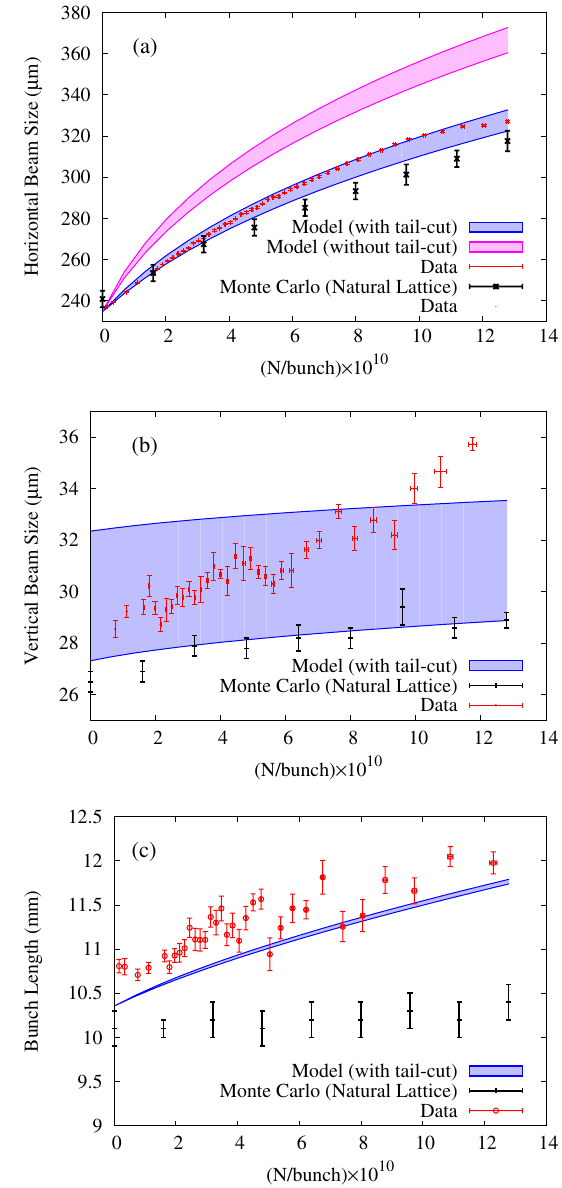
FIG. 9. (a) Horizontal, (b) vertical, and (c) longitudinal beam size versus current for e þ bunch in conditions tuned for minimum vertical